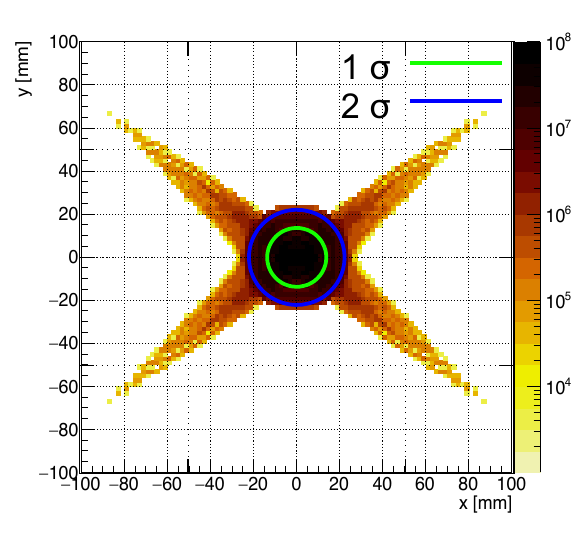
Figure 12. Simulated spot at the focal plane. Green and blue cir- cles are defined as a spot size with 95% and 68% photons inside.